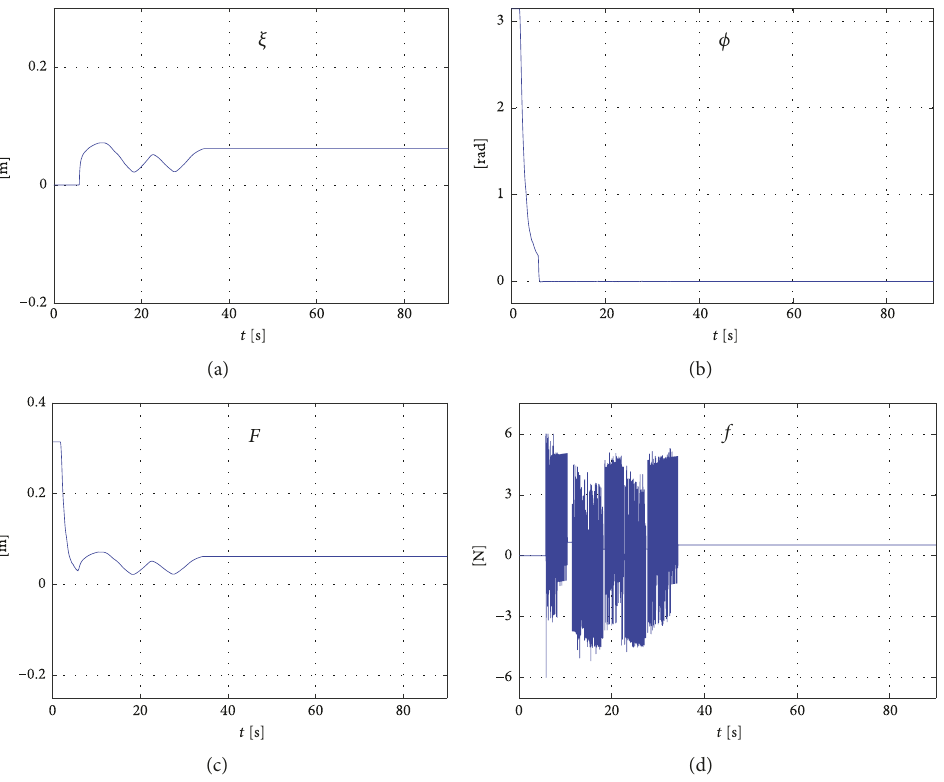
Figure 14: Experimental results when |𝐺(𝑗𝜔 𝜎 )| = 36 and 𝜔 𝜎 = 8 rad / s.